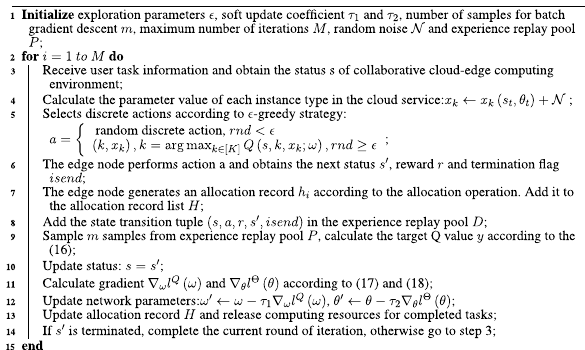
Algorithm 2. Cost Ef fi cient Resource Allocation with public cloud (CERAU).